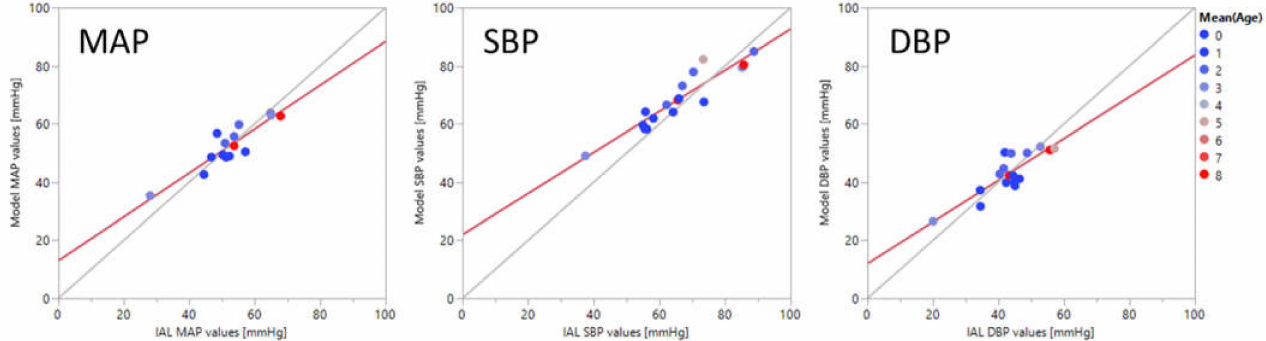
Figure 6. Plots of convolutional neural network model outputs vs. invasive arterial line ground truth values of mean arterial pressure (MAP), systolic (SBP), and diastolic (DBP) blood pressure values averaged over each individual. The points are color coded for the patients’ age in